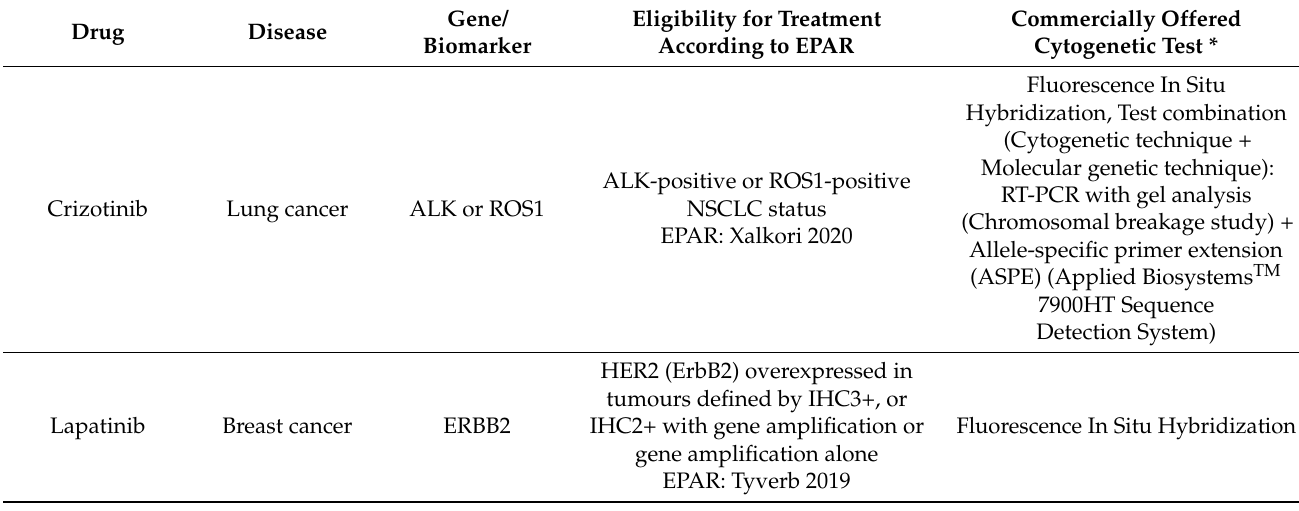
Table 1. GTR-registered tests identified via screening by drug. IHC: Immunohistochemistry, FISH: Fluorescence in situ hybridization, SISH: Silver in situ hybridization. According to entries of the Genetic Testing Registry for EMA approved drugs, for which testing is recommended or mandatory or annotations on actionable pharmacogenomics are present (according to the respective